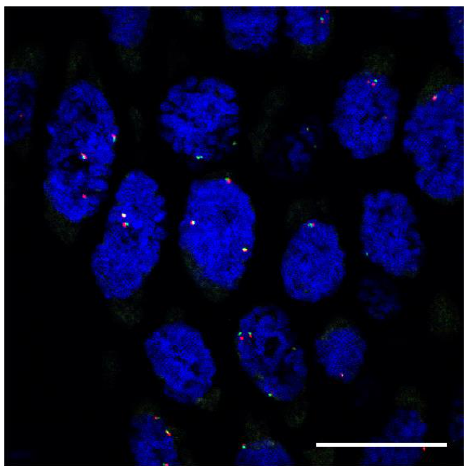
Figure 4. Fluorescent in situ hybridization with MAML2 break-apart probes of the present case. Bar, 20 μm. In the present case, the tumor cells showed no split signal of MAML2 probes (overlapped red and green signals). A triple overlap signal in the individual nuclei was frequently observed, which might indicate aneuploidy.